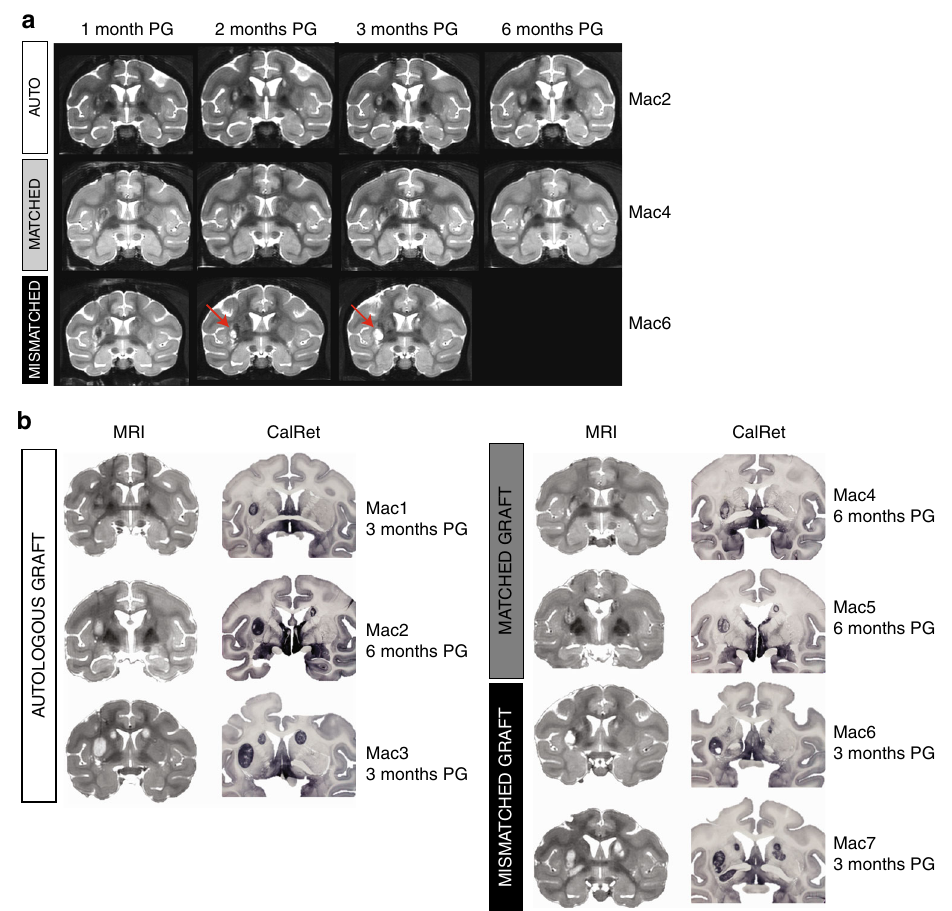
Fig. 4 Graft size, location in QA-lesioned NHPs analyzed in vivo with MRI. a Representative coronal images of the longitudinal MRI follow-up of CTP derivatives after intra-striatal transplantation in autologous (white), MHC-matched (gray) and MHC mis-matched (black) recipients showing areas of hyper- (red arrows) and hypo-intensity in the caudate (bilateral) and putamen (unilateral, left) corresponding to the transplanted CTPs at 1, 2, 3 and, where applicable, 6 months post-surgery. b Graft MRI images prior to euthanasia and on post mortem sections stained with CalRet in autologous (white), MHC- matched (gray) and MHC mismatched (black) recipients at end-point (3 months PG for Mac 1, 3, 6, 7; 6 months PG for Mac 2, 4,